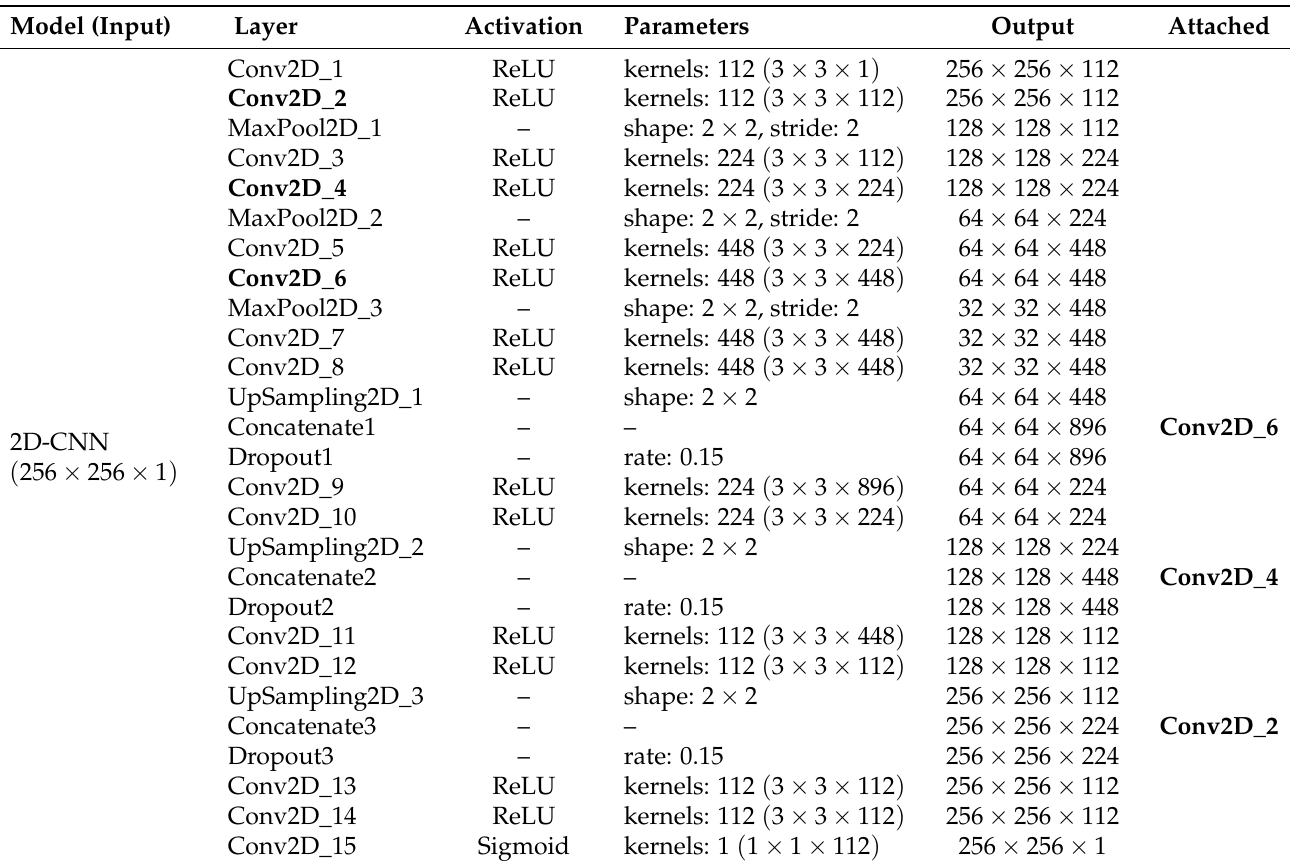
Table 5. The Deep Moon architecture utilized for detecting Moon craters. All layers are connected sequentially with a few exceptions of additional skip-connections, specified in the “Attached” column. The bolded layers have been added during the model reshaping, as discussed in the following part of the manuscript (Section